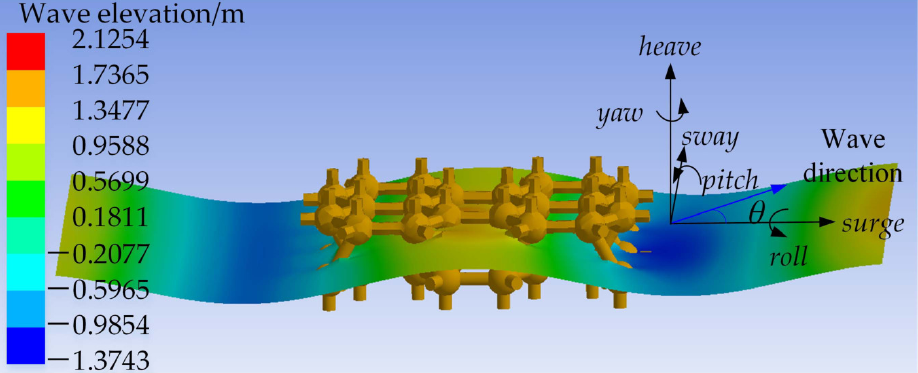
Figure 7. Visualization of the interaction between the BDFF and waves.